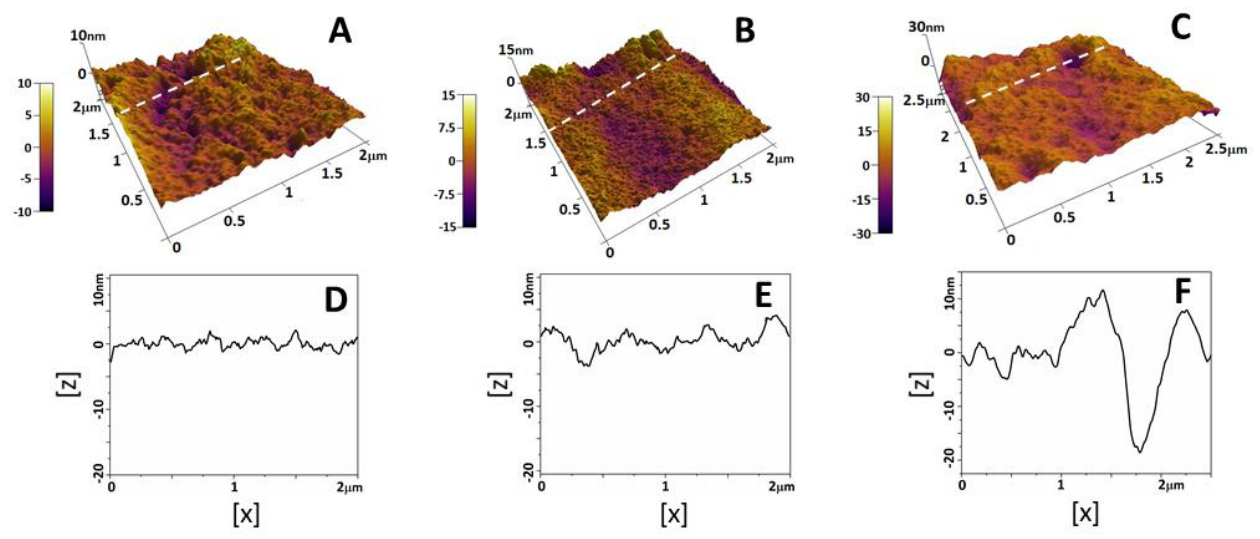
Figure 1. 3D high-resolution images of membrane nanostructure of freshly isolated RBCs from non- pregnant controls (NPCs, ( A )) and pregnant controls (PCs, ( B )) and from patients with preeclampsia (PE, ( C )). The height profiles defined by the dashed lines on panels ( A – C ) are presented on panels ( D – F ), respectively.